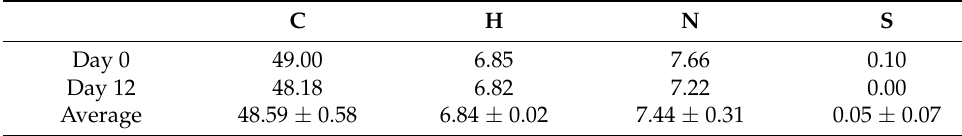
Table 1. Biomass ultimate analysis. Sample dry mass: 1 mg. C H N